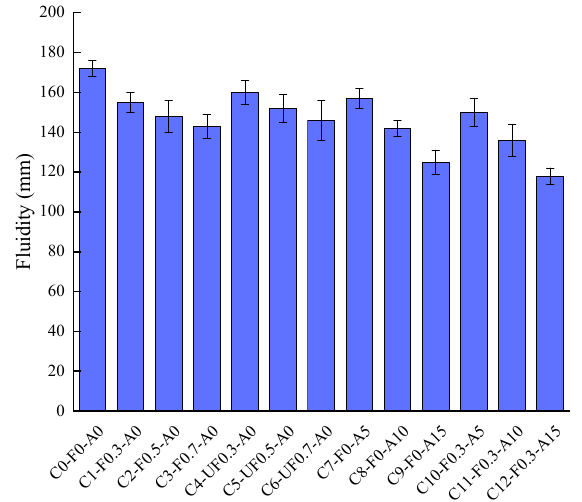
Figure 6. Effects of YDF and YDA content on the fluidity of cementitious mortars.